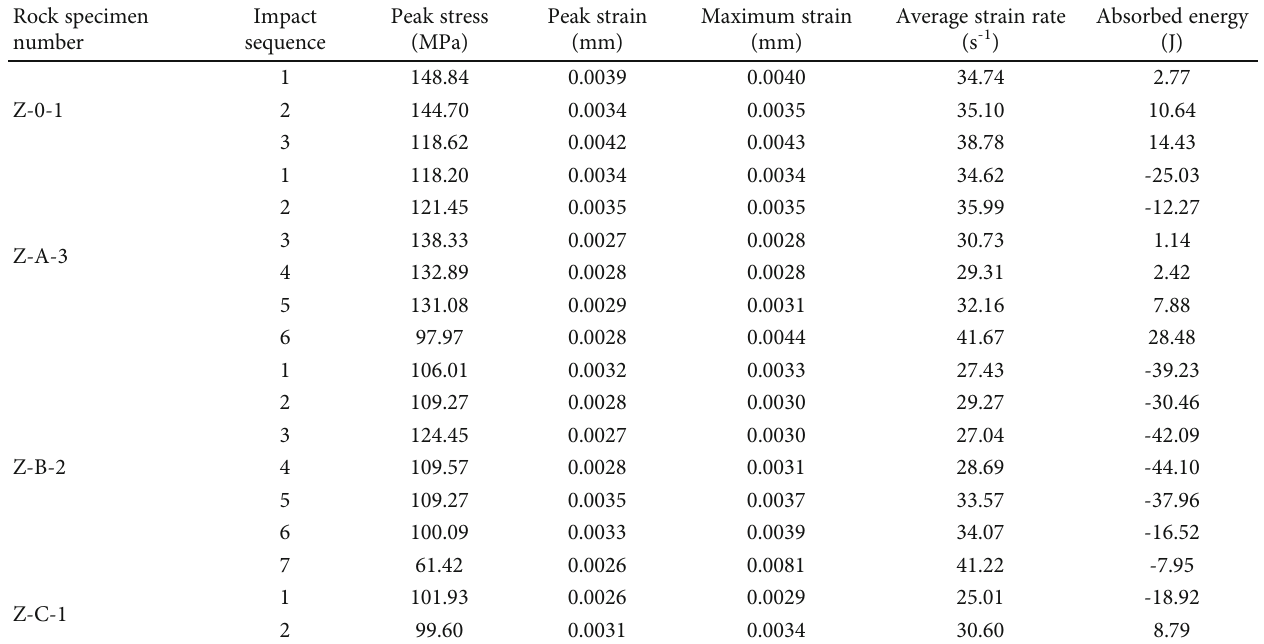
Table 2: Test results of the rock